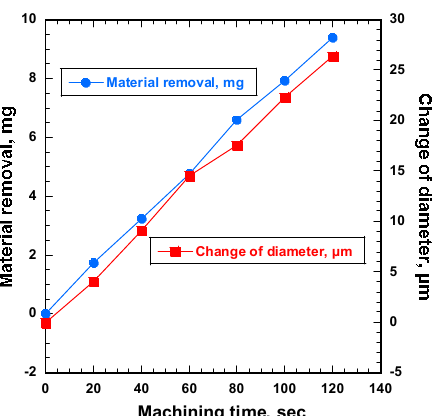
Figure 6. Change of diameter and material removal weight against the machining time at 80,000 rpm (10 Hz, 550 mT, and 0.5 µm).